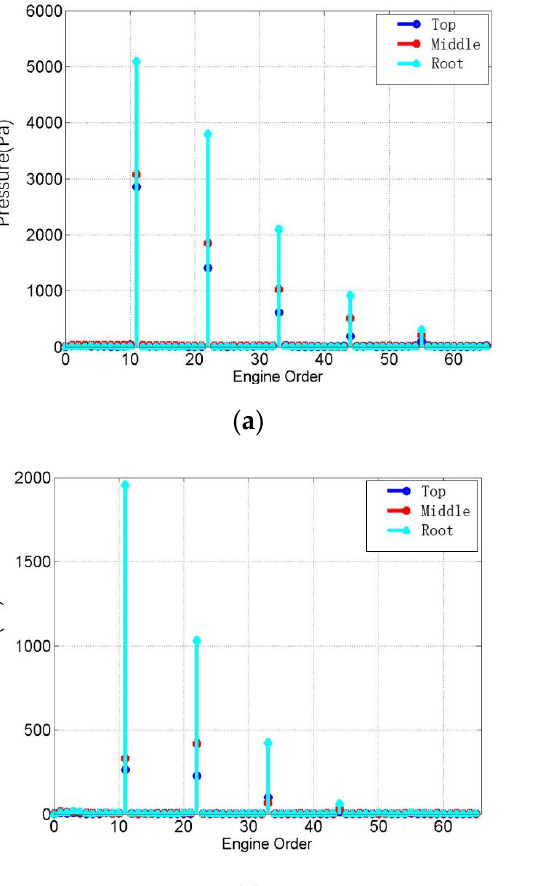
Figure 6. Frequency spectra of monitoring points on the rotor ( N s = 11): ( a ) leading edge; ( b ) basin; ( c ) back; and ( d ) trailing edge.